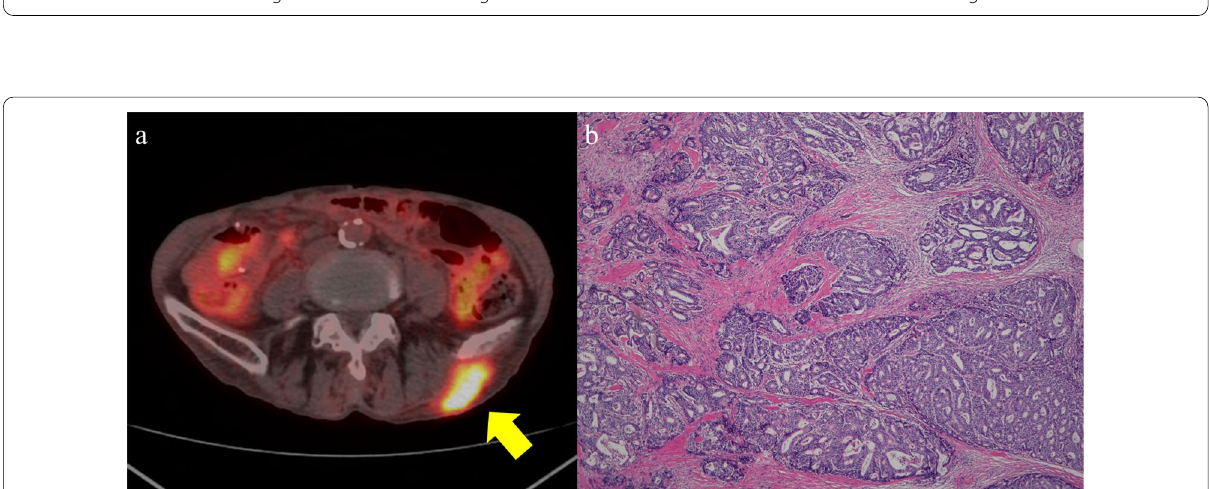
Fig. 5 Computed tomography (CT) scan and pathological findings of the third recurrence. a Positron emission tomography (PET)/CT scan shows an elevated FDG intake in the lateral area of the left iliocostalis lumborum muscle. b Pathological examination reveals an adenocarcinoma consistent with metastatic tumor from gastric